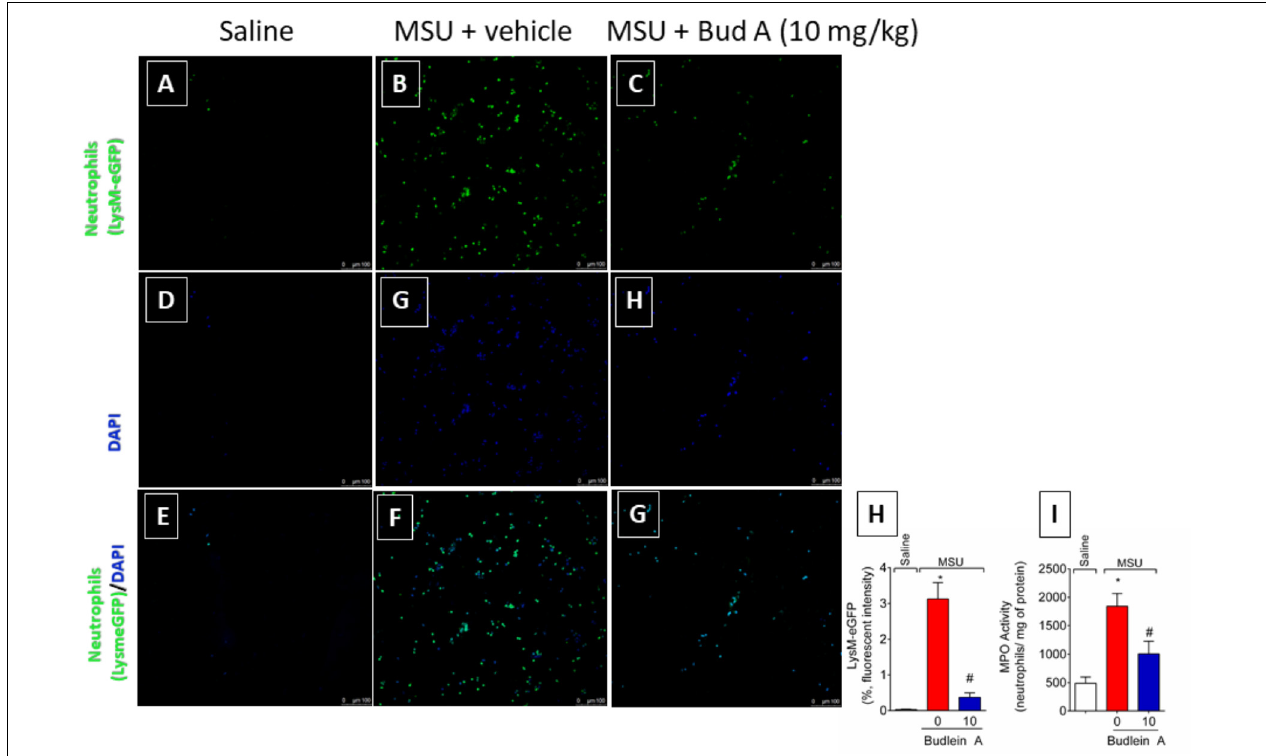
FIGURE 4 | Fifteen hours after the injection of MSU crystals, knee joint wash of LysM-eGFP mice was collected for quantification of fluorescence intensity [Original magnification 20 × , panels (A-G) ] using a confocal microscope. Percentage of fluorescence is represented in panel (H) . Knee joint of Swiss mice was dissected for determination of neutrophil recruitment assessed by determination of MPO activity (I) by a colorimetric method. ∗ p < 0.05 vs. saline group; # p < 0.05 vs. 0 mg/kg group, one-way ANOVA followed by Tukey’s post hoc